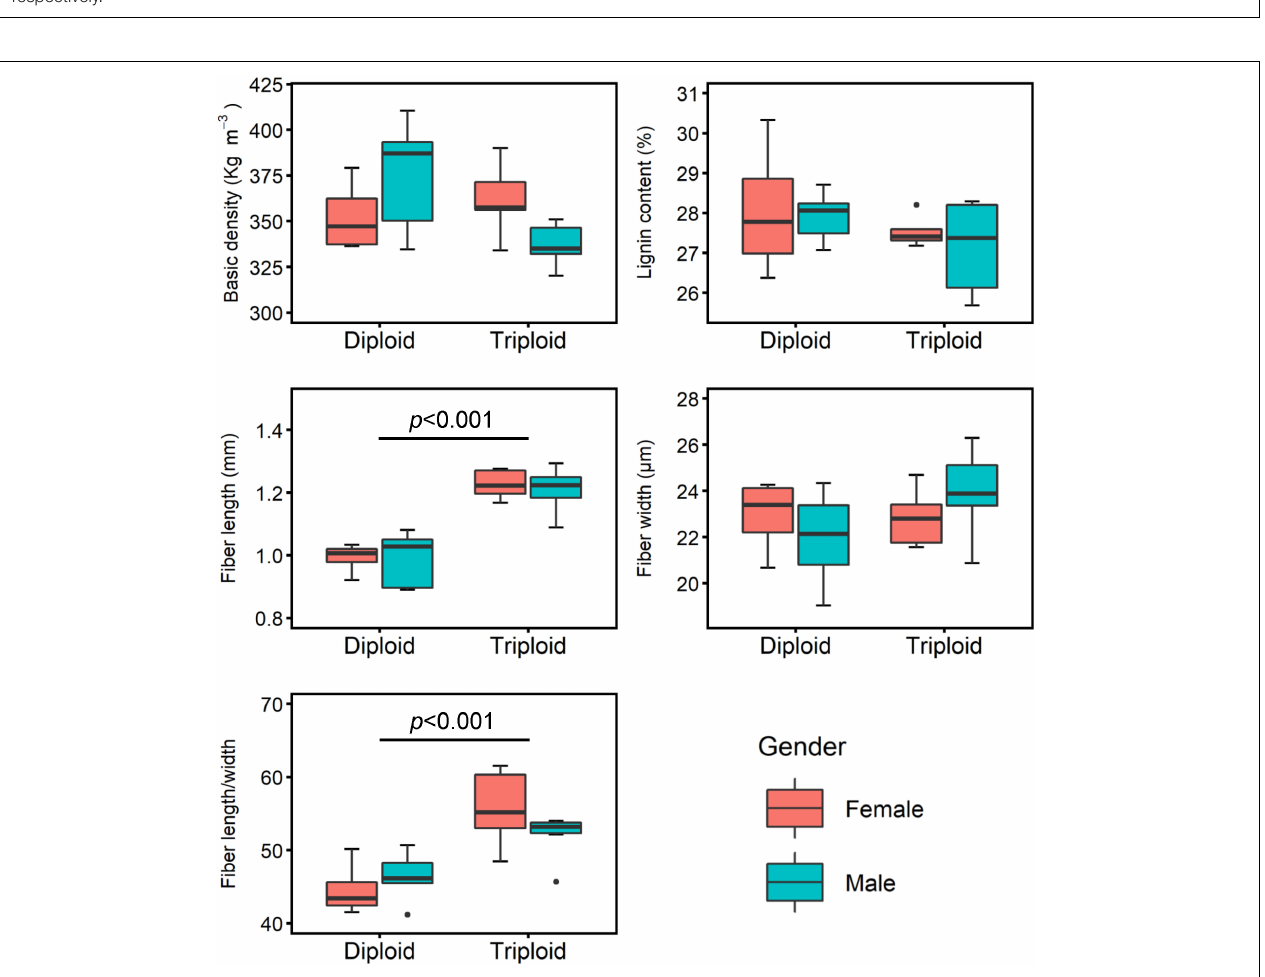
FIGURE 4 | Comparisons between diploid and triploid groups and between female and male groups within the ploidy levels for wood and fiber traits.